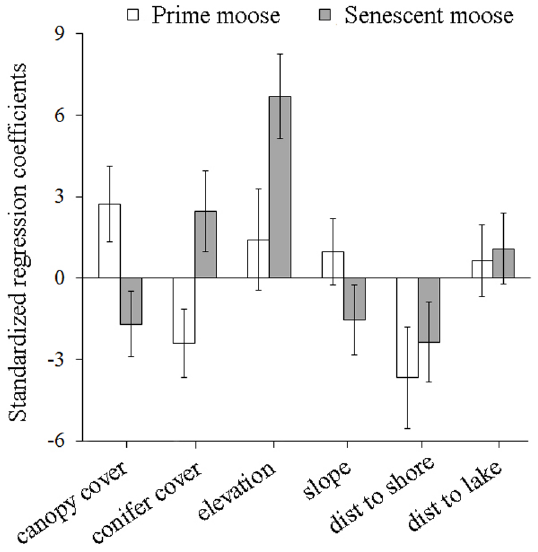
Figure 3. Standardized regression coefficients with standard error bars from the multiple linear regression model describ- ing habitat features at prime and senescent moose kill sites in Isle Royale National Park, Lake Superior, USA, 2000–2008. The response variable for this model was the percentile of the kernel density estimate (see Fig. 1) at each site where a moose was wolf-killed which depicts the probability of kill occurrence. Distance to shore refers to the Lake Superior shoreline, and distance to lake refers to inland lakes within Isle Royale.